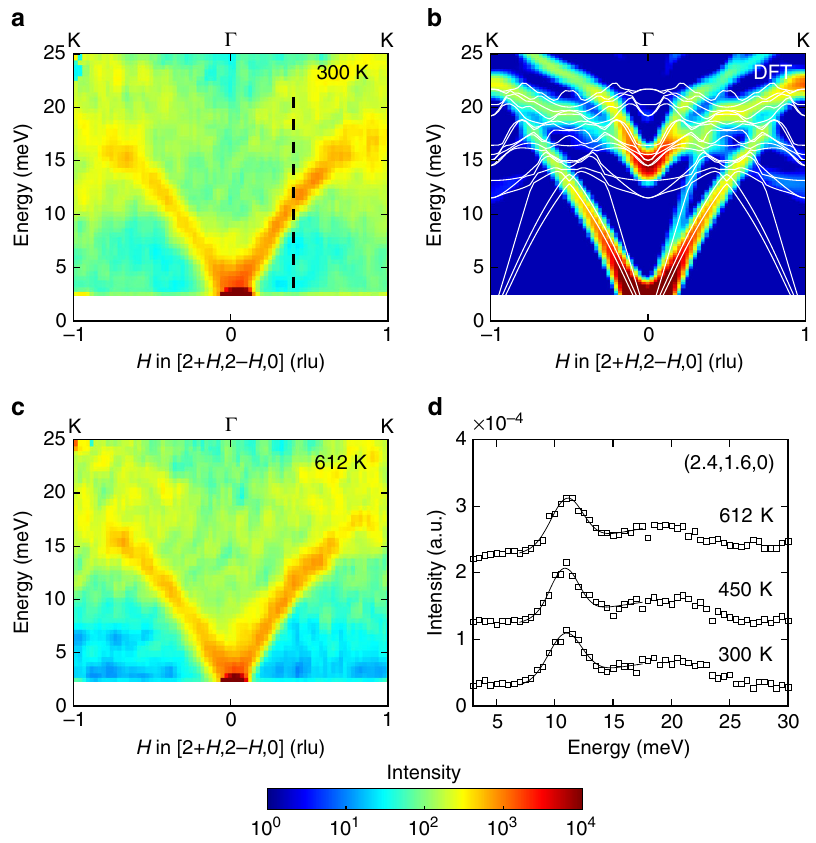
Fig. 3 Dynamics of the K 1 distortion in the FE phase. a , c χ ″ ( Q , E ) along the [2 + H , 2 − H , 0] direction at T = 300, and 612 K compared with calculated intensity from DFT simulations (white lines are calculated phonon dispersion curves in b ). d 1D spectra at Q = (2.4, 1.6, 0) (black dotted line in a ). The integration range in a – c along perpendicular Q directions is from − 0.2 to 0.2 rlu, while for 1D cuts, the integration range along H is from 0.35 to 0.45 rlu. To improve the statistics of 1D cuts, data at equivalent point Q = (1.6, 2.4, 0) are summed with data at Q = (2.4, 1.6, 0). Γ and K high symmetry points in a – c refer to the PE phase notation. Error bars are smaller than the size of markers. The data are measured on ARCS instrument. The offset for different temperature points is for